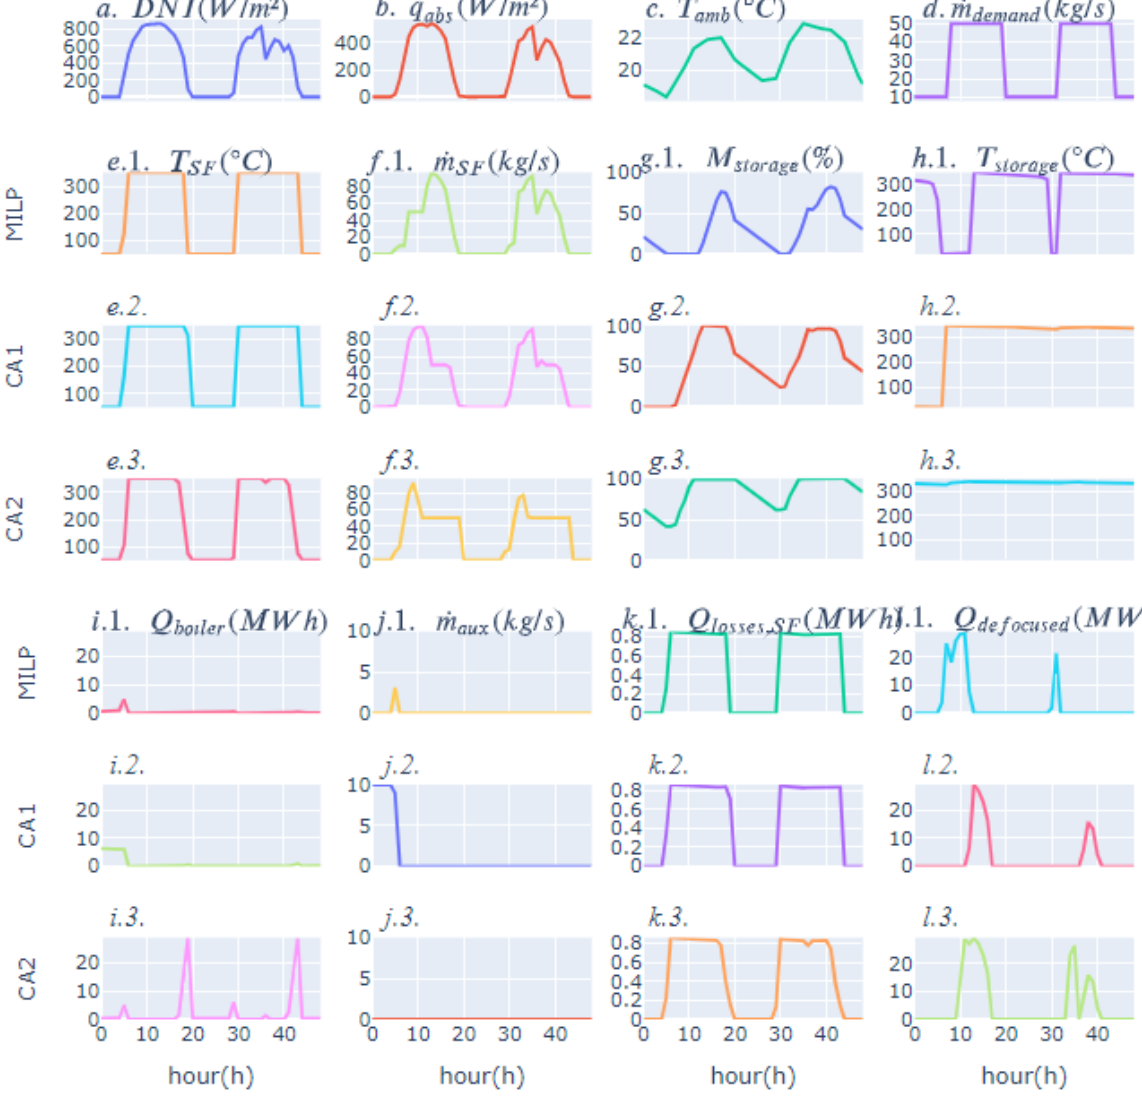
Figure 7. Simulation results in summer, on 22nd–23rd of June.